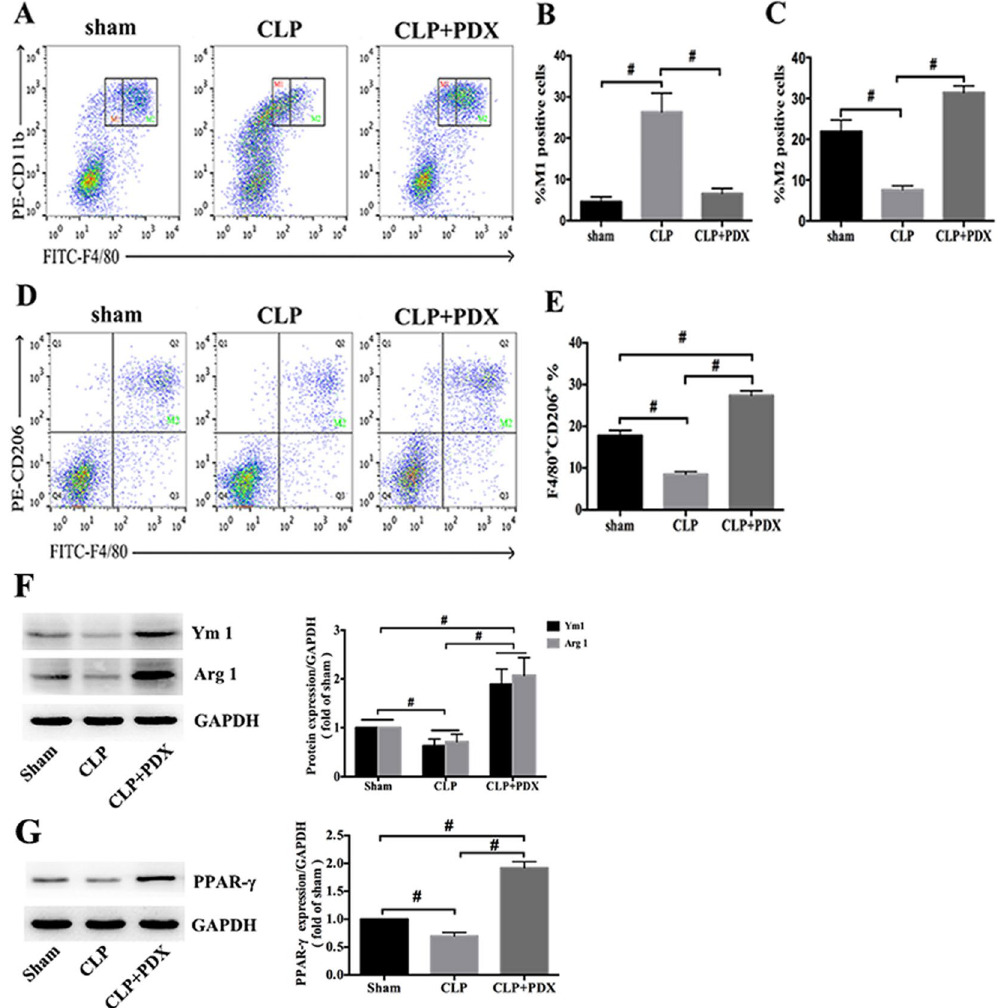
Figure 6. PDX enhanced M2 polarization from peritoneal cavity of septic mice. Peritoneal macrophages were harvested and detected by flow cytometry 24 h after CLP. M2 macrophages (F4/80 hi CD11b hi ) were reduced sharply in CLP group when compared with sham group ( A , C ). And M1 macrophages (F4/80 int CD11b hi ) were increased obviously in CLP mice ( A , B ). PDX administration significantly increased M2 macrophages (F4/8 + CD206 + ) in peritoneum of septic mice ( A – E ). The protein levels of Arg1, Ym1 ( F ) and PPAR- γ ( G ) were measured by western blot. Quantification for protein expression was normalized by GAPDH. Data represented the mean ± SEM (n = 6). * P < 0.05, # P <